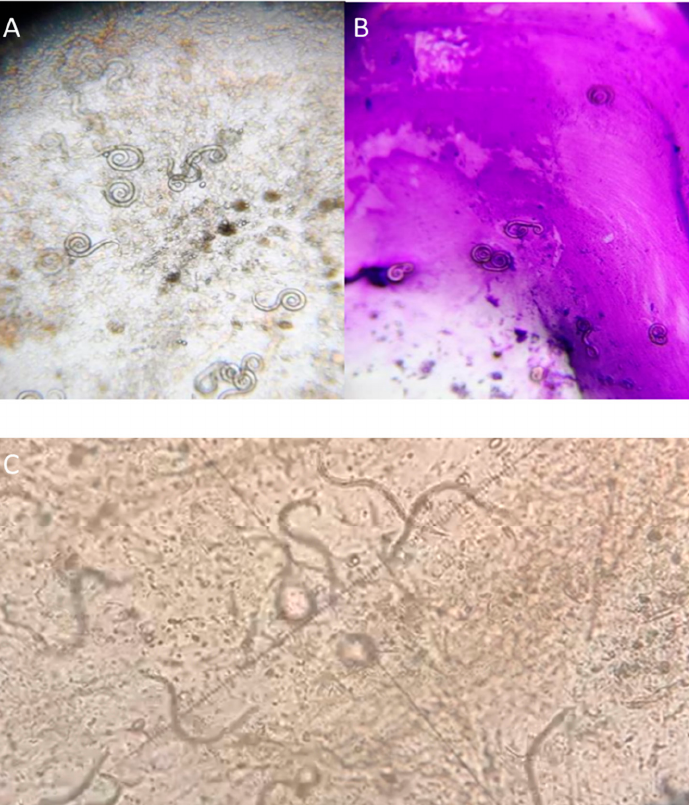
Figure 4. Direct microscopic examination of the expectorated sputum, showing numerous larvae of Strongyloides stercoralis ( A – C panels). Papanicolau staining ( B panel). The Strongyloides stercoralis HS syndrome was, therefore, diagnosed, and subcutaneous treatment with ivermectin, 200 µg/kg/day on alternate days, was started. Due to the severe constipation, a stool examination was not